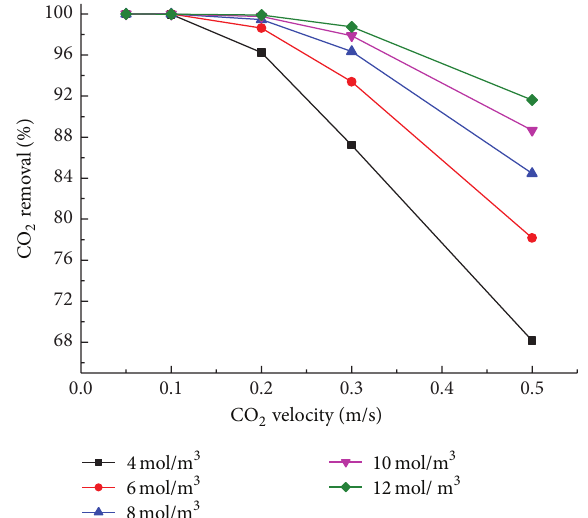
Figure 8: Removal percentage under different gas velocity. 𝑟 1 = = 0.2 mm, 𝑟 = 0.3 mm, 𝐿 = 900 mm, 𝐶 0.15 mm, 𝑟 2 3 = 0.5 ms −1 . 0.5 molm −3 , and V MEA